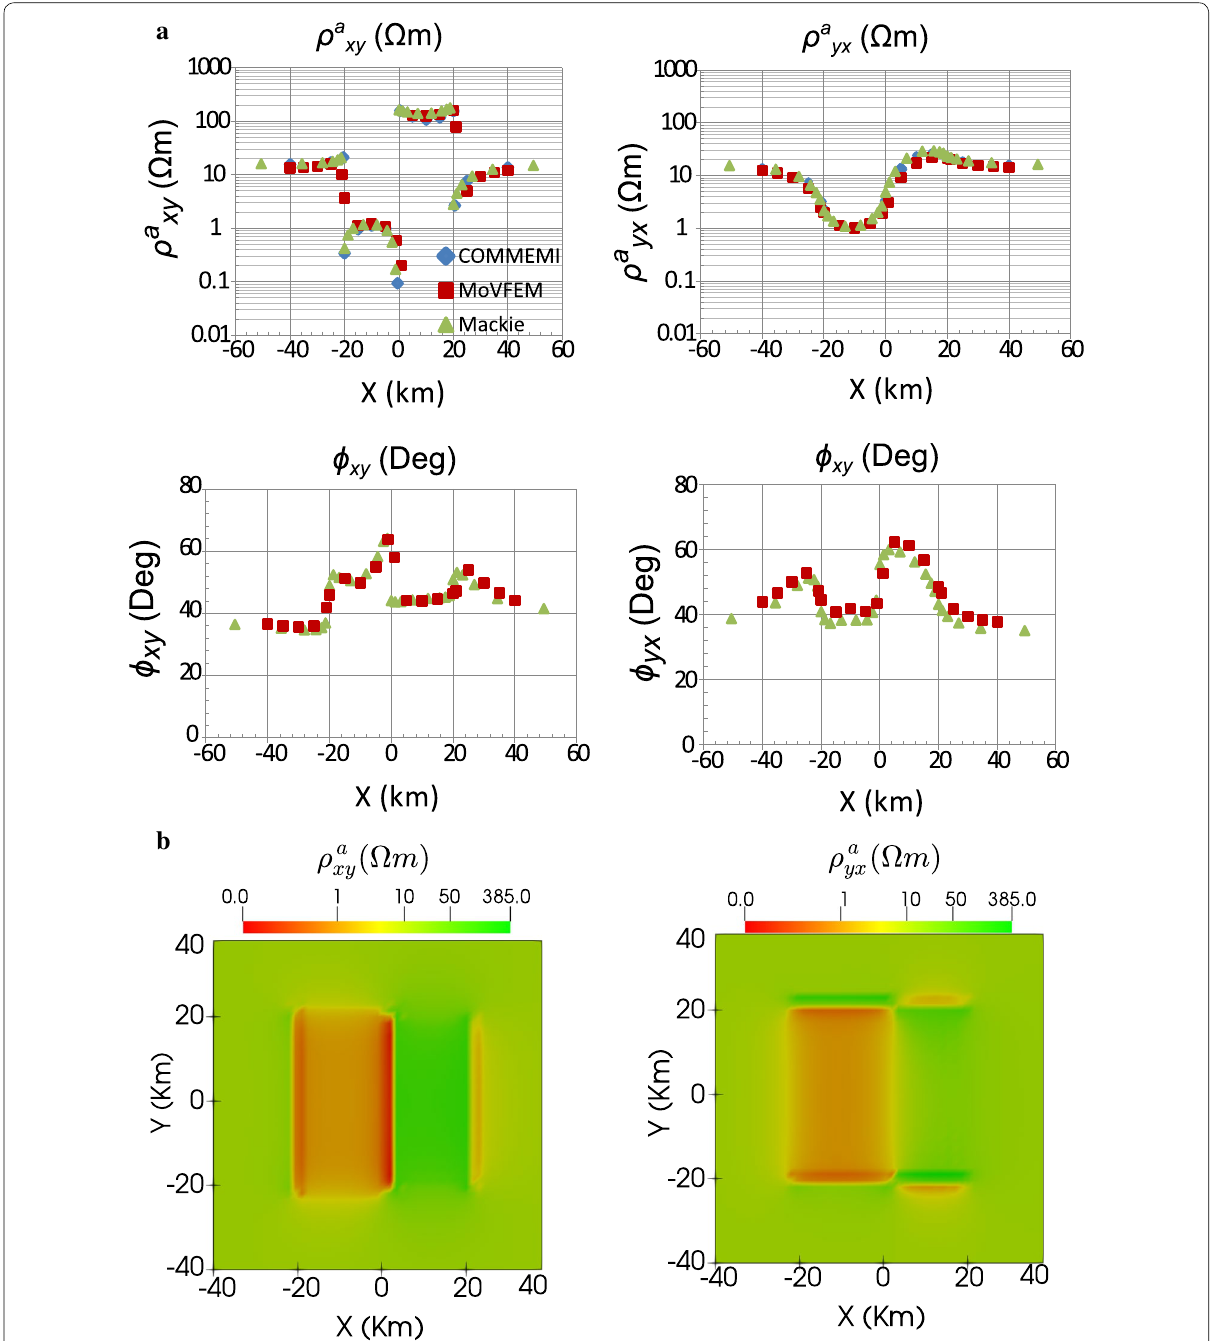
Fig. 10 Modeled MT responses of COMMEMI 3D‑2. Apparent resistivity and phase angles for a signal of 0.01 Hz. a Response curves of xy ‑(left) and yx ‑(right) polarizations. Values are taken at the model surface along the profile y ≡ 0, x ∈ [ 0,2 ] km. Bottom plots show phase angle results. Results for MoVFEM and two references models are displayed. b Map view of apparent resistivities at the model surface for xy ‑(left) and yx ‑(right)